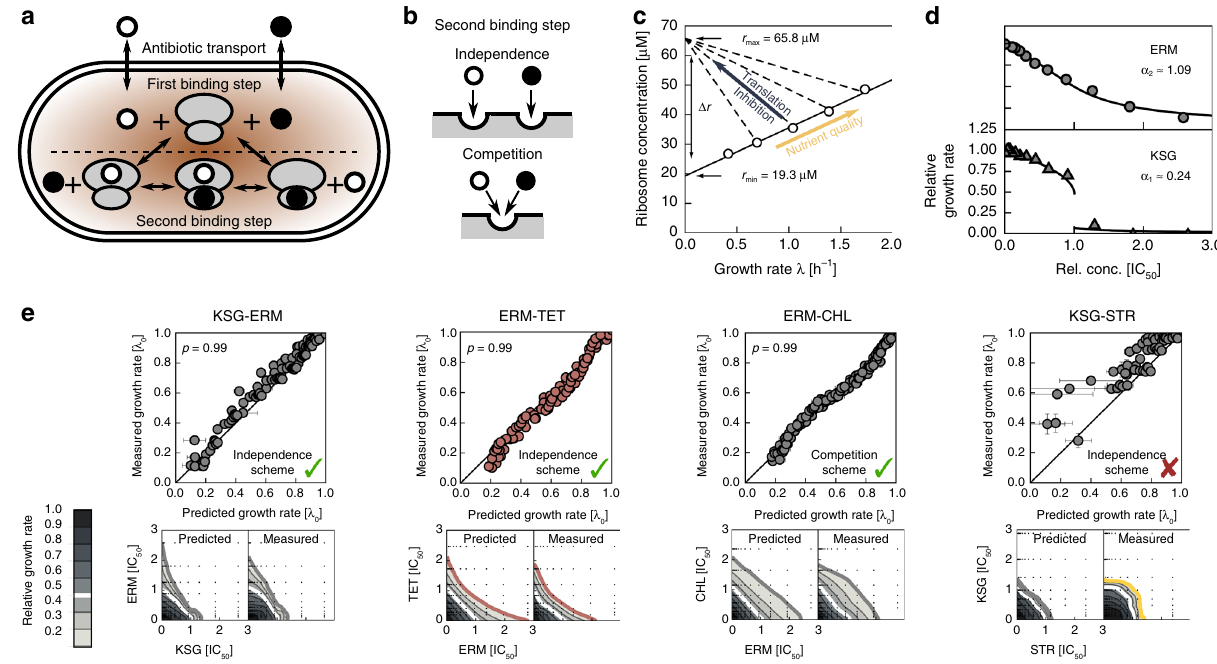
Fig. 2 Mathematical model partially predicts drug interactions. a Schematic of antibiotic binding and transport into the cell. Antibiotics (circles) bind to the unbound ribosomes (gray) in the fi rst binding step (above dashed line); bound ribosomes can be bound by a second antibiotic (second binding step; below dashed line). b Schematic of antibiotics binding independently (top) or competing for the same binding site (bottom). c Growth laws link intracellular ribosome concentration to the growth rate. Solid line: ribosome concentration when the growth rate is varied by varying nutrient quality; dashed lines: ribosome concentration when the growth rate is lowered by perturbation of translation. Circles show data from ref. 14 . d Data points are dose – response curves for ERM and KSG; lines show the best- fi ts of the mathematical model. The best- fi t values of the response parameter α that encapsulates kinetic and physiological parameters (Supplementary Information) are shown. Both shallow (top panel, ERM) and steep (bottom panel, KSG) dose – response curves are observed. e Examples of predicted dose – response surfaces. The scatter plot depicts the correlation between predicted and measured growth rates. Means and error bars (standard deviation) of predicted growth rates are estimated from n = 100 bootstrap repetitions. The binding scheme assumed is indicated on the bottom right and Pearson ’ s ρ on the top left. Predicted and measured dose – response surfaces are shown below the scatter plot. Color of 20% isobole (bottom) denotes the type of predicted interaction. The model correctly predicts response surfaces for KSG-ERM, ERM-TET, and ERM-CHL, yet it fails to predict the interaction between STR and